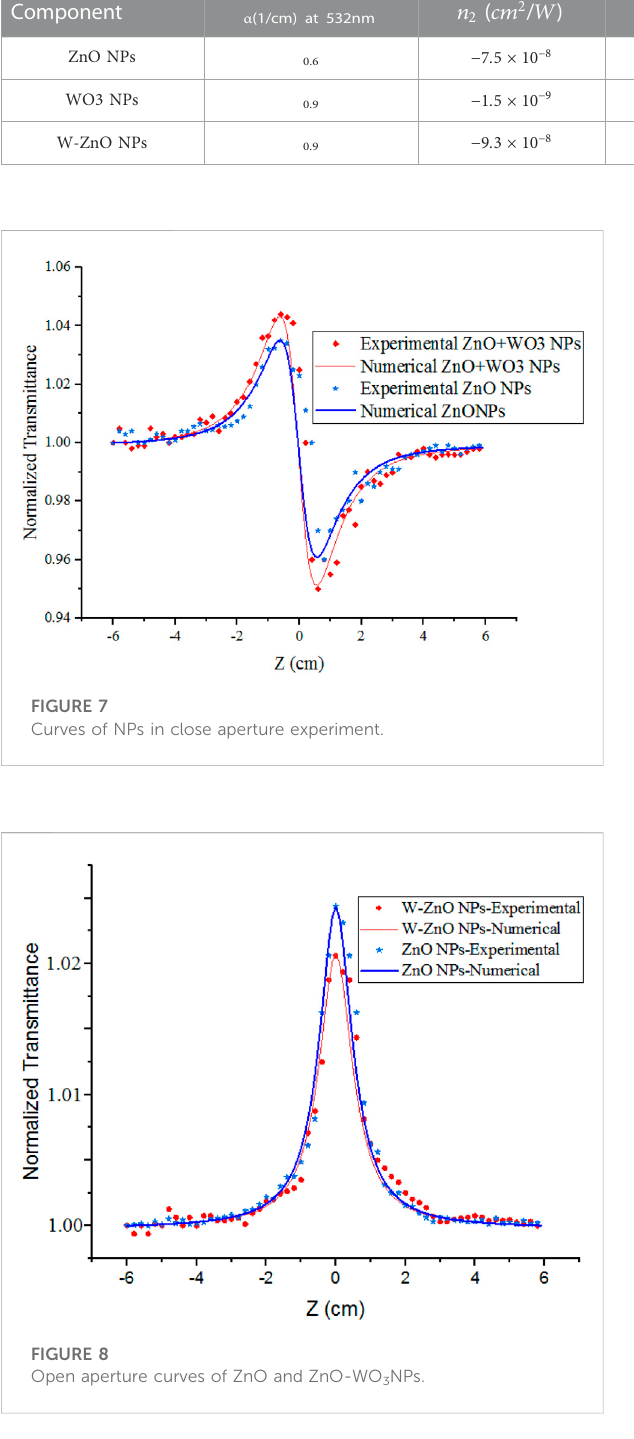
TABLE 1 Optical coef fi cients of synthesized NPs, measured using a CW Nd-Yag (green) laser. Component